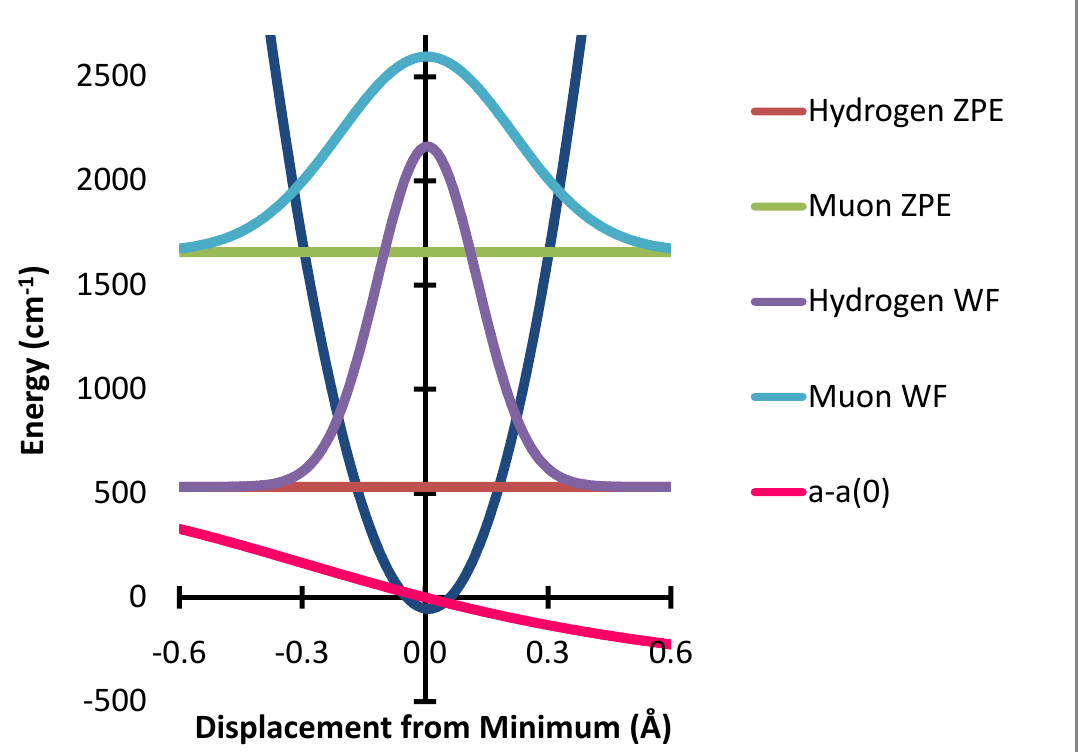
Figure 3. In-plane bending potential (dark blue) with zero point energy levels and probability distributions for H and Mu and variation of a–a(0) Gauss ×